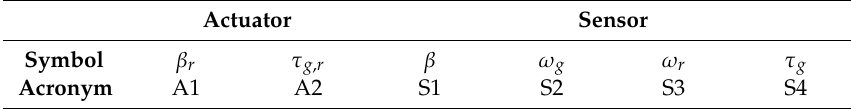
Table 2. Symbols and acronyms of the actuator and sensor for 4.8 MW wind